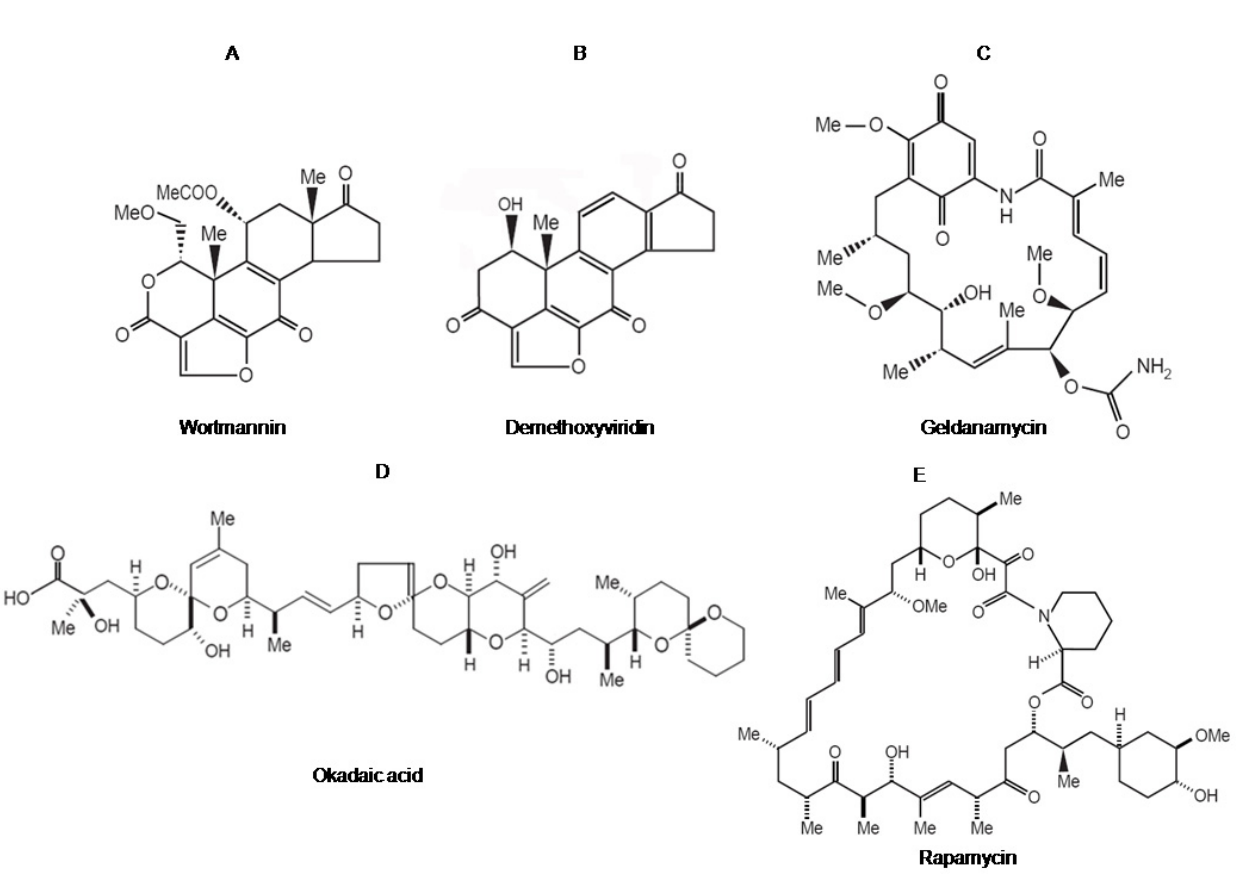
Figure 1 . Molecular structures of natural products that inhibit insulin